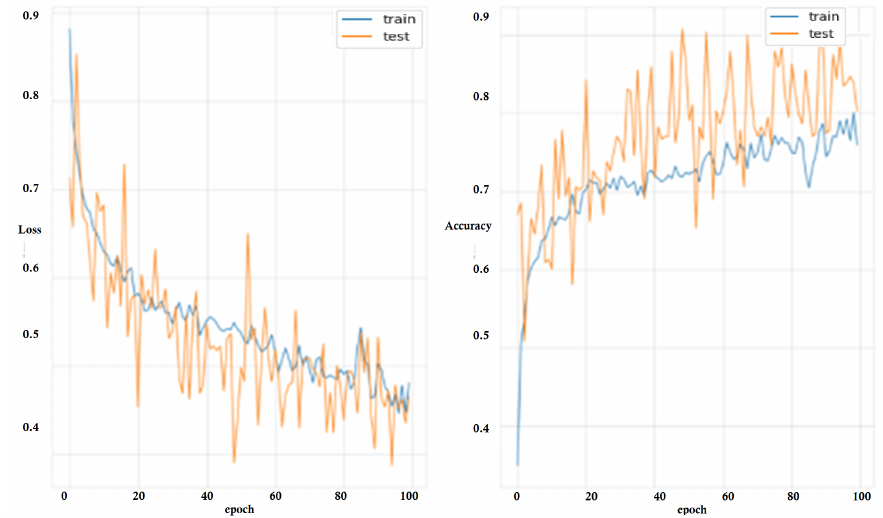
Figure 16. Classification Loss and Accuracy using CNN/VGG-19 network model.